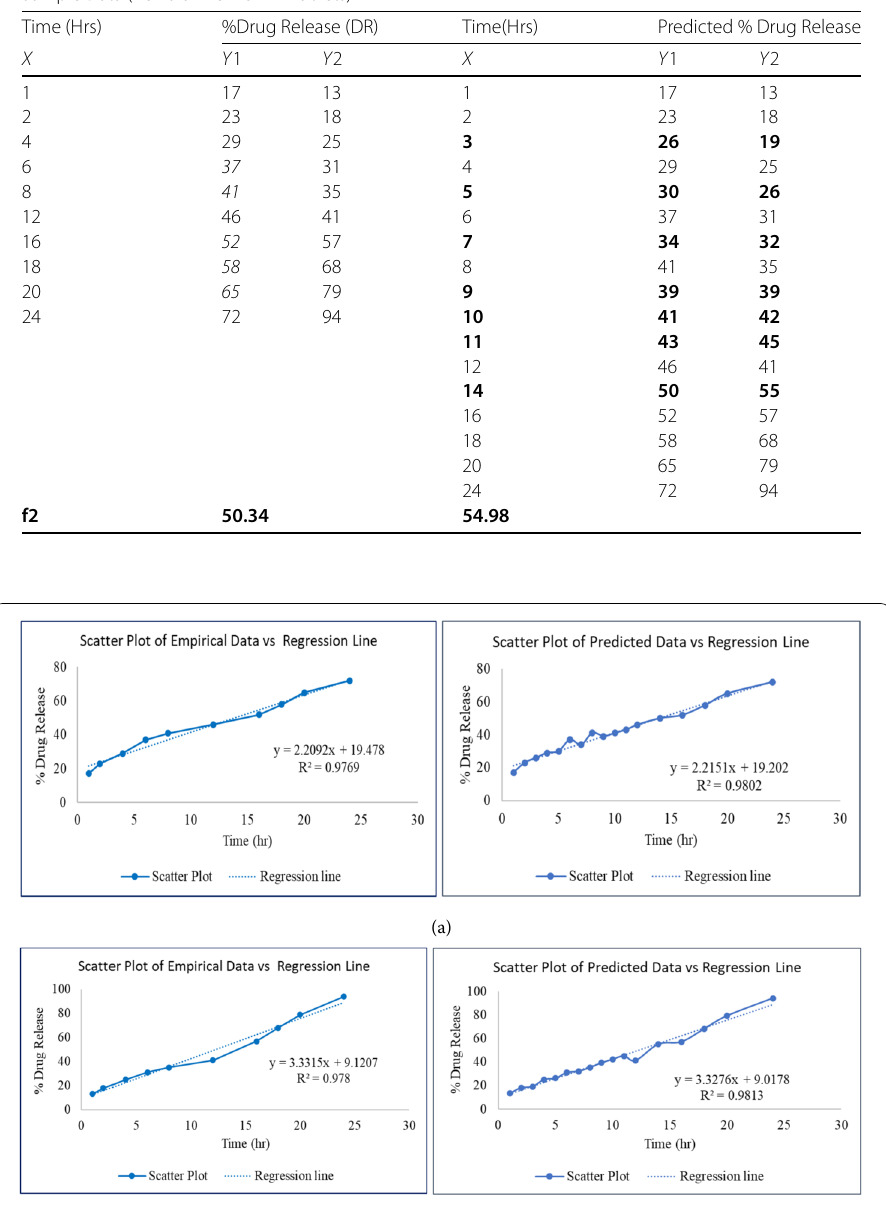
Table 4 Comparison of two drug release profiles of Venlafaxine HCl MR Tablets Sample Data (Venlafaxine HCl MR Tablets)